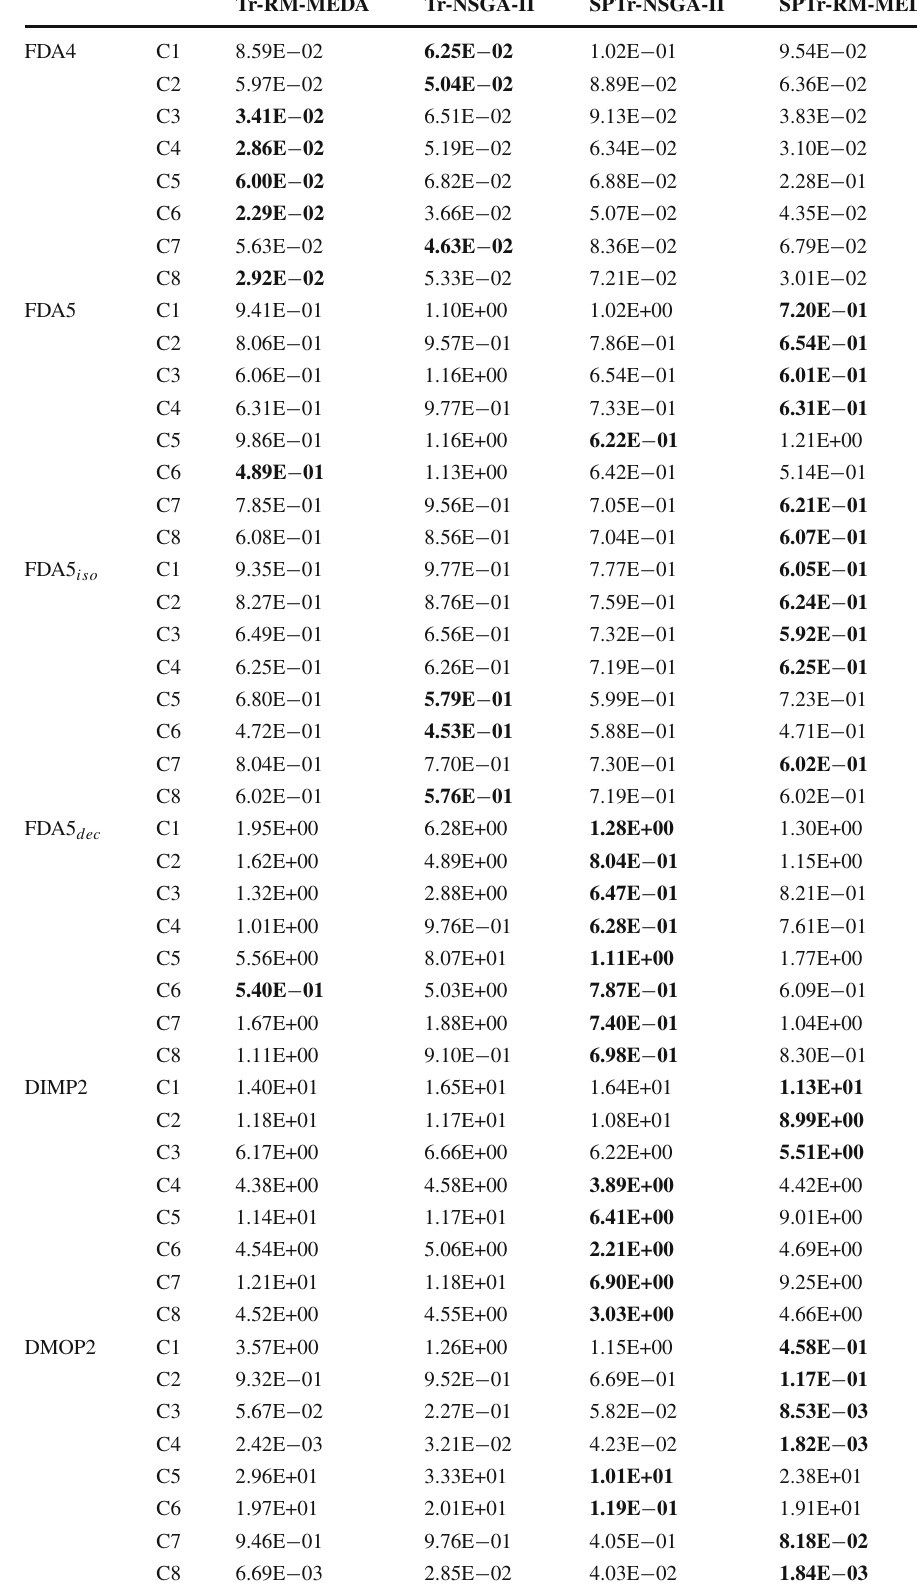
Table 4 The MIGD of 12 test functions compared with Tr-RM-MEDA and